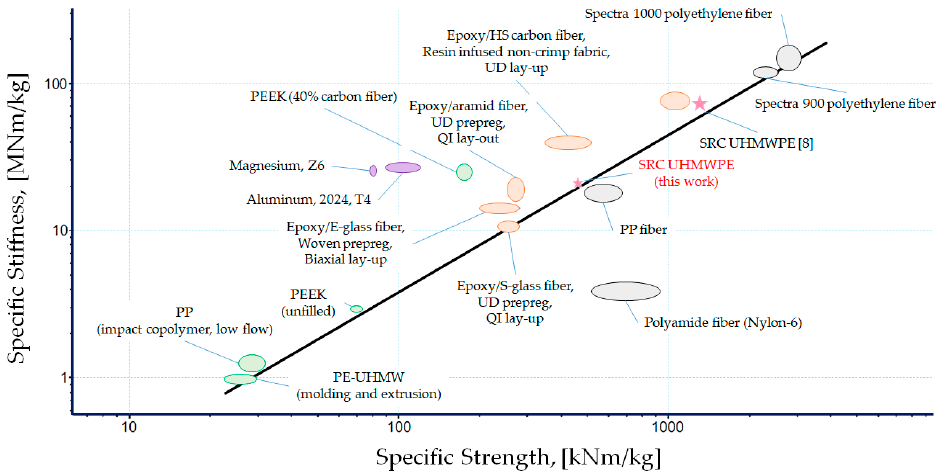
Figure 1. Ashby plot for various materials illustrating the range in specific strength and specific stiffness